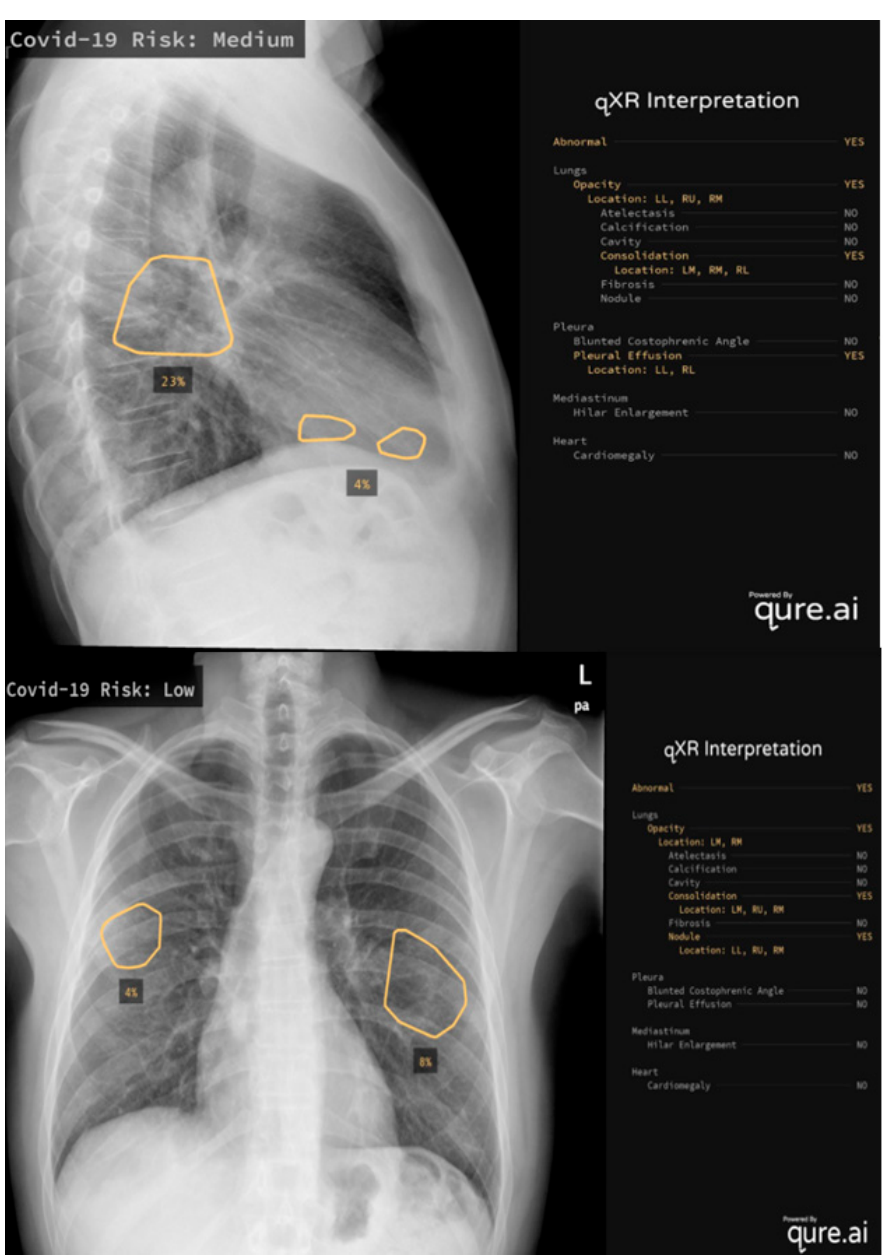
Figure 1. Two examples of qure.ai application, the algorithm calculates the risk levels, evaluating lungs, pleura, mediastinum and heart on CXR.